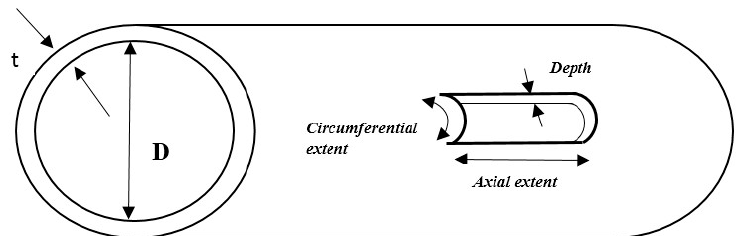
Figure 5. Three-dimensional defect parameters (radial depth, axial extent, and circumferential extent); D: pipe diameter; t: thickness.